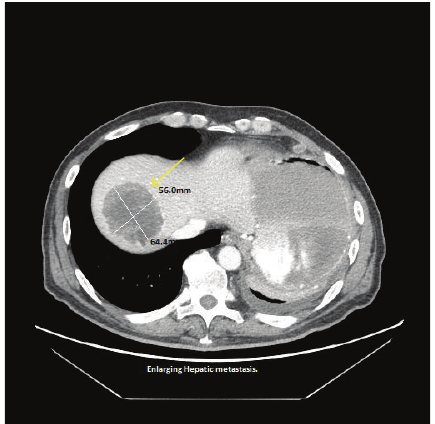
Figure 2: Previous CT (contrast enhanced) showing liver metas- tases (yellow arrow) smaller at that time and no perihepatic fluid.